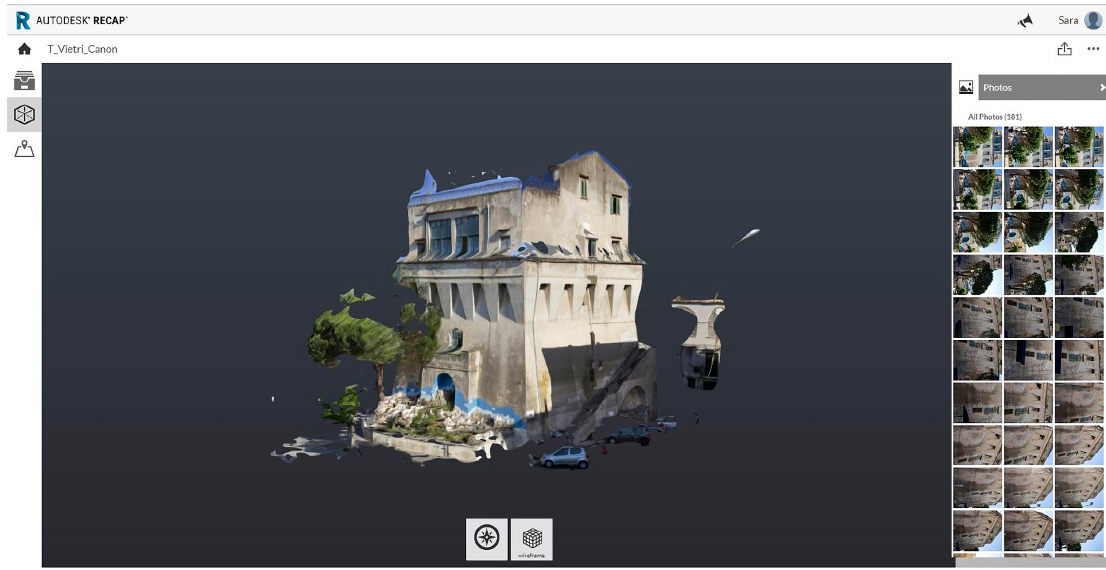
Figure 5. 3D model generated with ReCap Photo